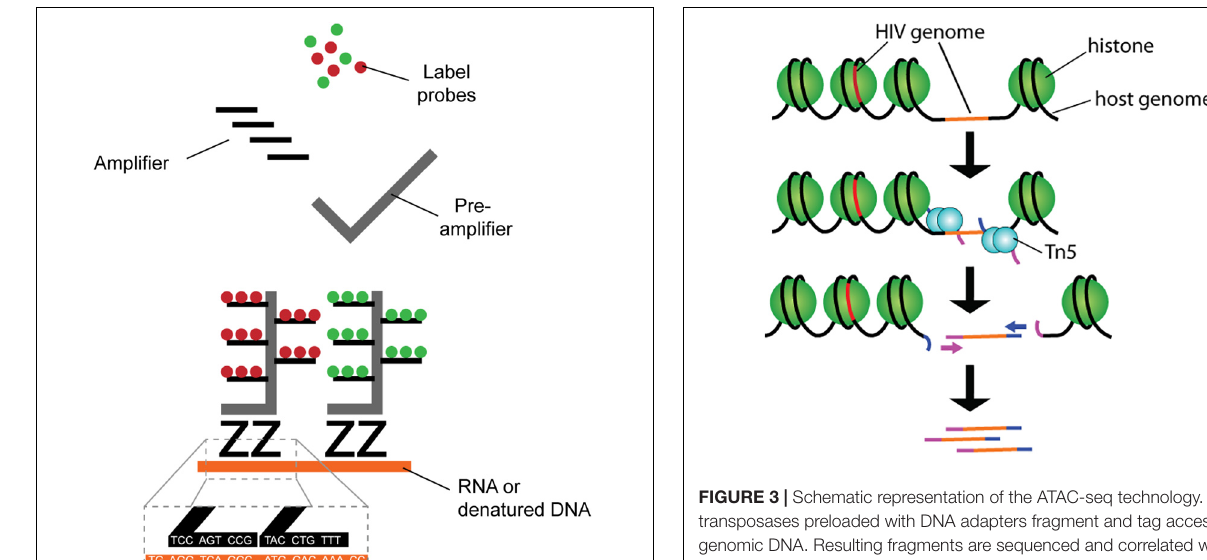
Frontiers in Microbiology |